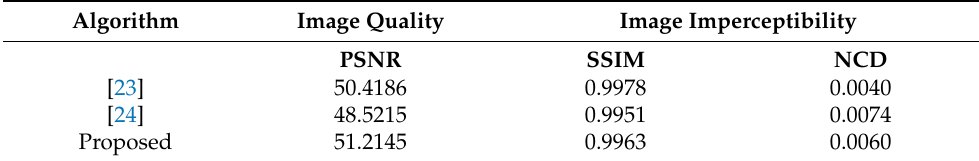
Table 10. Image quality and watermark imperceptibility comparison.